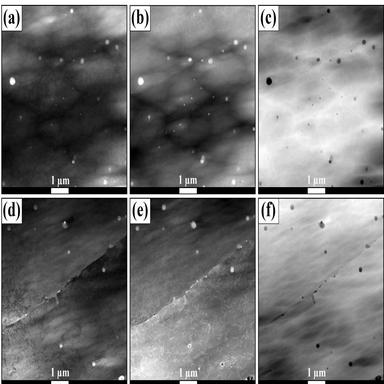
High-magnification HR-STEM images from the dispersion of reinforcing alumina nanoparticles within the stainless steel metal-matrix after layer-upon-layer deposition of LPBF treatment: (a, d) BF, (b, e) DF, and (c, f) HAADF contrast structures.